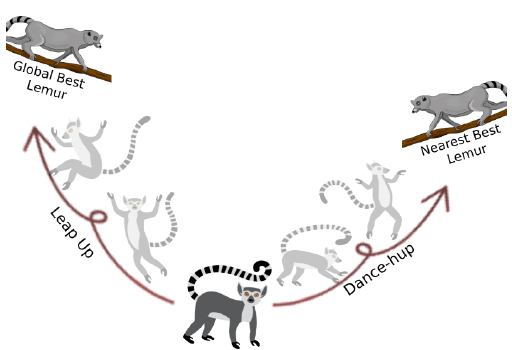
Figure 3. Lemur Optimizer Inspiration.